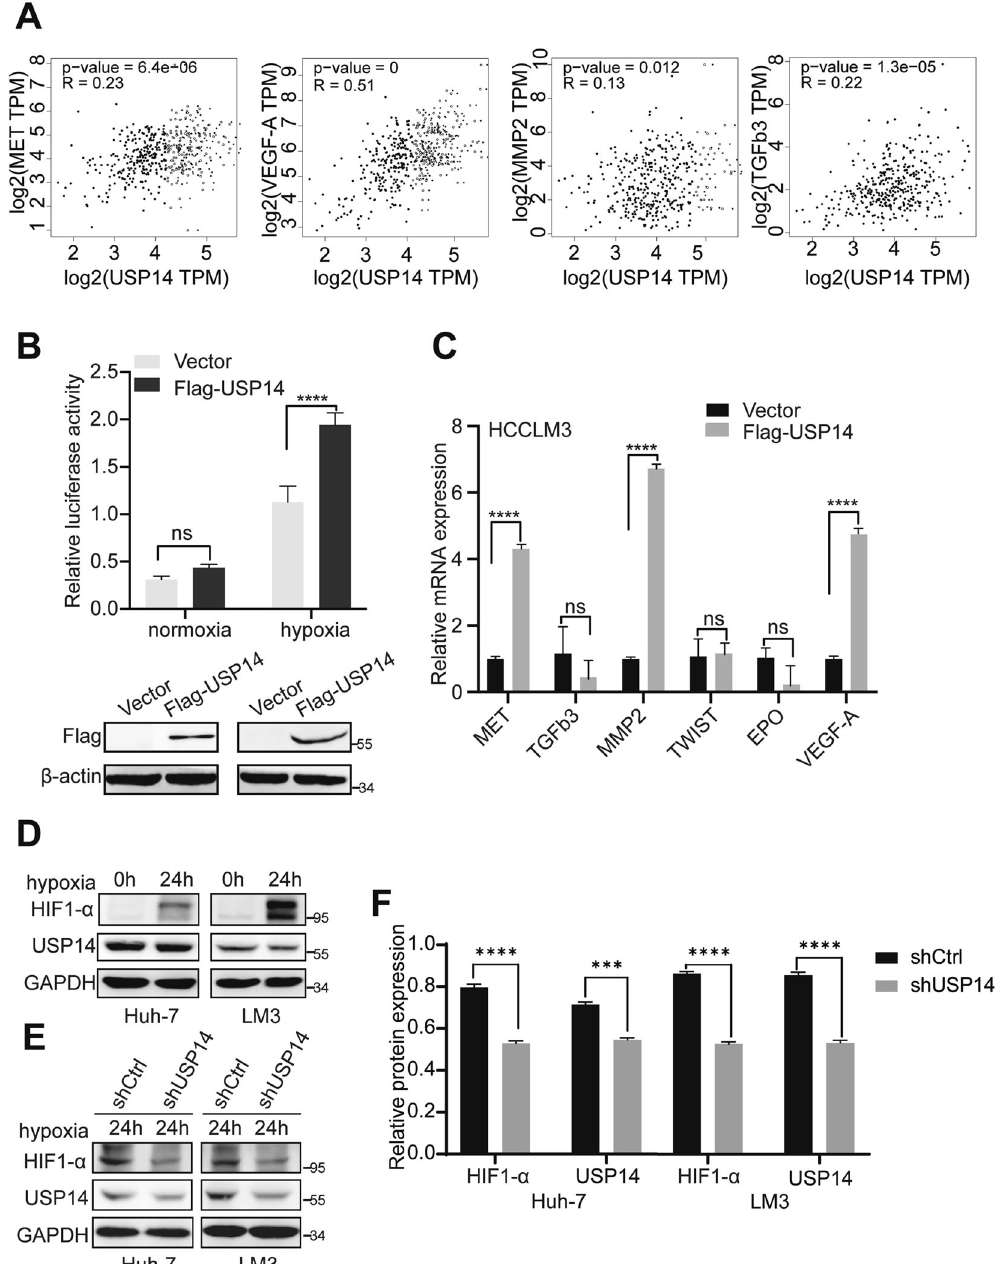
Fig. 2 USP14 enhances HIF1- α -mediated transactivation in HCC cells. A Studies from the GEPIA database presented the correlation between USP14 mRNA expression and HIF1- α target genes ’ mRNA. B Fold change in the relative luciferase activity was examined by luciferase reporter assay in USP14 overexpression or vector HCCLM3 cells incubated under normoxia or hypoxia (in 1% O2 incubator) for 24 h (up panel). Cell lysates from the luciferase reporter assay were collected and analyzed simultaneously by immunoblotting (down panel). C Real-time PCR analysis showed the effect of USP14 overexpression on activation of HIF1- α target genes in hypoxia. D HIF1- α protein increased in two HCC cells under hypoxia state induced by CoCl 2 . E The protein expression levels of HIF1- α in control and USP14 knockdown HCC cells were examined by western blot. F Quanti fi cation of protein expression is shown as histograms on the right. In the histogram, the bars represent the mean ± SD ( n = 3), * P < 0.05, ** P < 0.01, *** P < The above results suggested USP14 promotes HCC cell prolifera- for rescue experiments. The restoration of HIF1- α expression tion partially in a HIF1- α -dependent manner. partially attenuated the suppression of the proliferative ability induced by USP14 depletion (Fig. 4D). Finally, we then performed fl ow cytometry analysis to examine the effect of USP14 on cell- USP14 promotes cell migration, invasion, and VM formation in HCC cells cycle distribution. The results revealed that knockdown of USP14 Hypoxia is a common phenomenon in HCC due to the large induced an increase in the percentage of G1 phase cells as well as consumption of oxygen and energy, which affects the metastasis, a decrease in the percentage of G2/M phase cells (Fig. 4E).